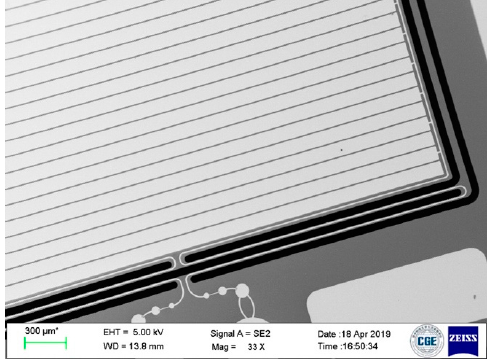
Figure 7. SEM image of the fabricated accelerometer chip.